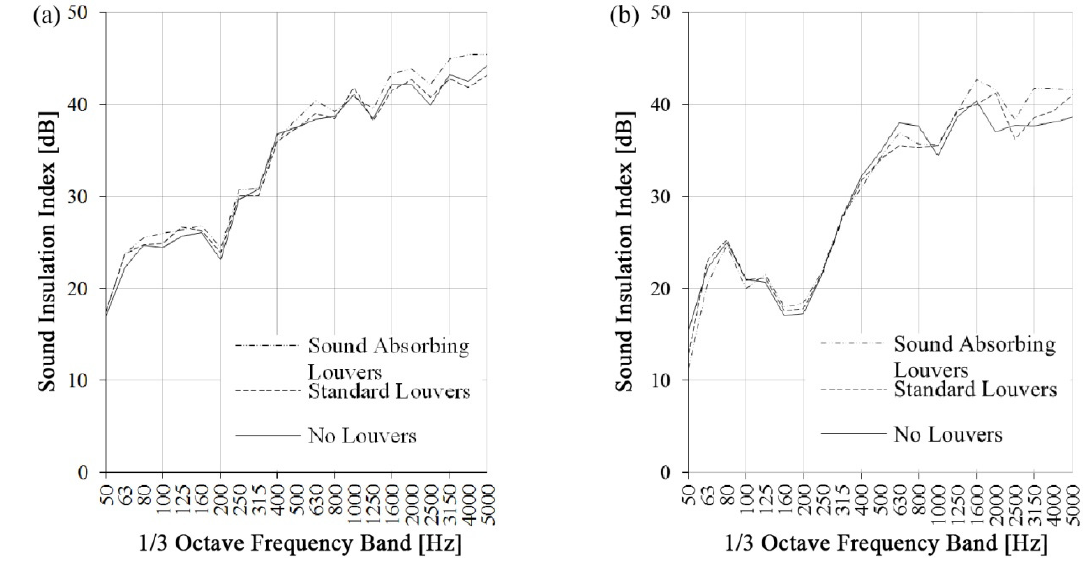
Figure 16. Façade sound insulation curves measured without louvers (solid lines), with standard louvers (dashed lines) and with sound absorbing louvers (dash-dotted lines). Louvers tilt angle is − 30°. ( a ) Ground floor façade portion; ( b ) third floor façade